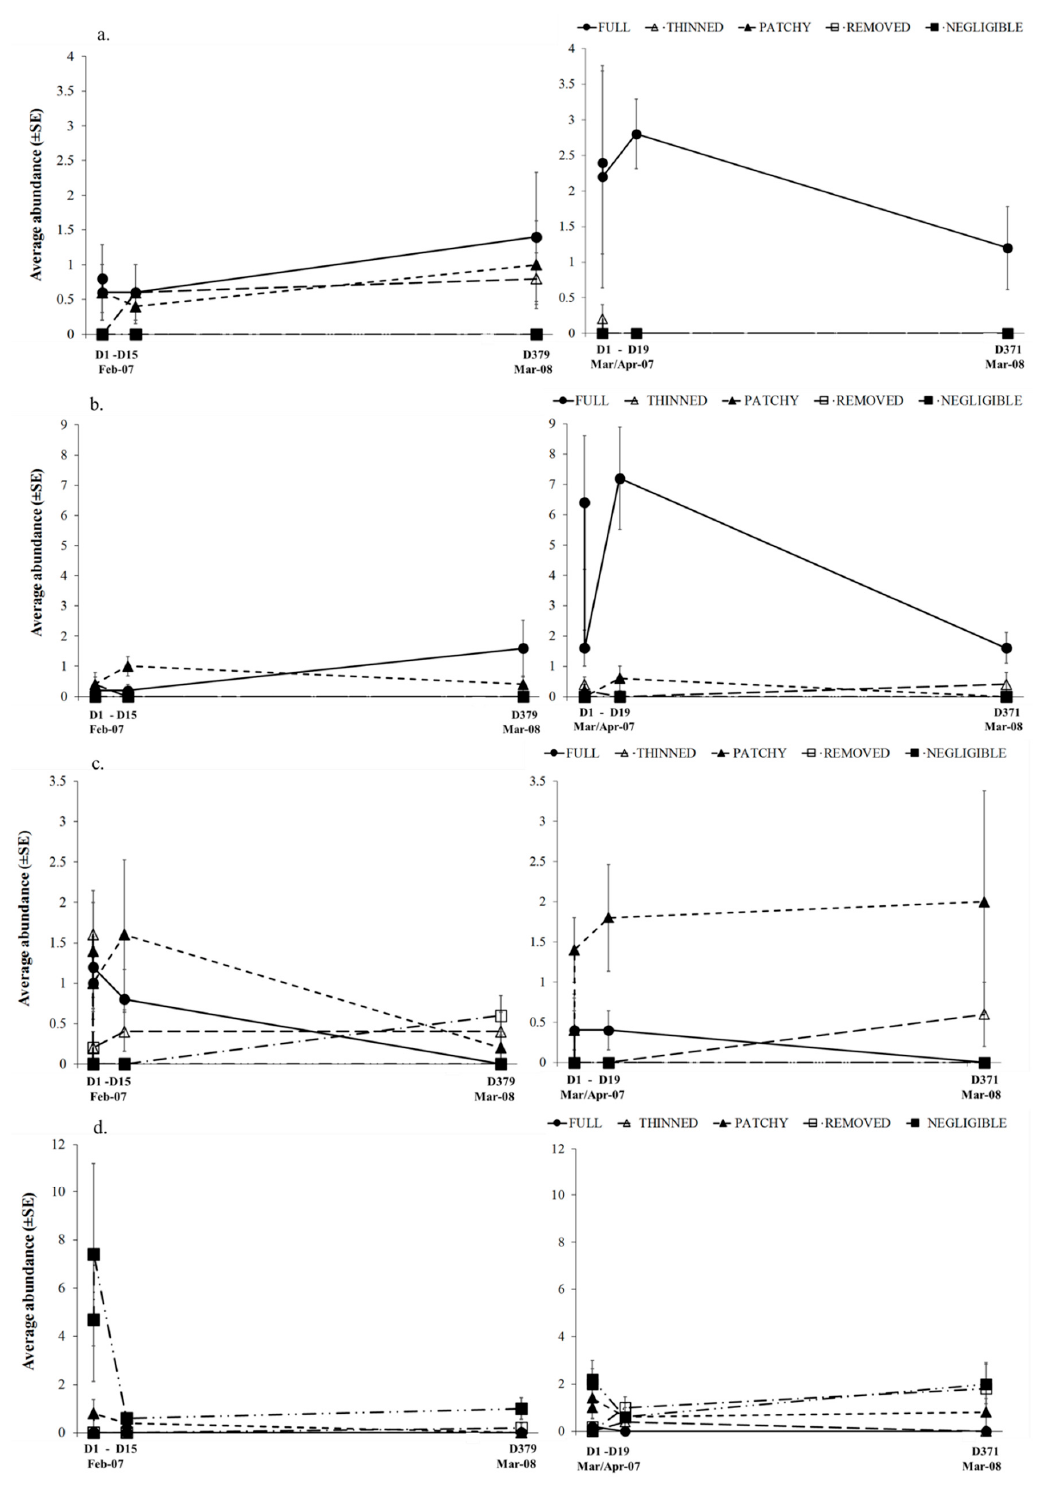
Figure 6. Mean ± SE percentage cover of ( a ) Lunella undulata ( b ) Chlorodiloma adelaidae, ( c ) Dicathais orbita ( d ) Bembicium nanum, for each treatment over time since manipulation of the canopy. 13th Beach on left hand site of the panel, Bridgewater Bay on right hand side. N = 5 for all treatments.